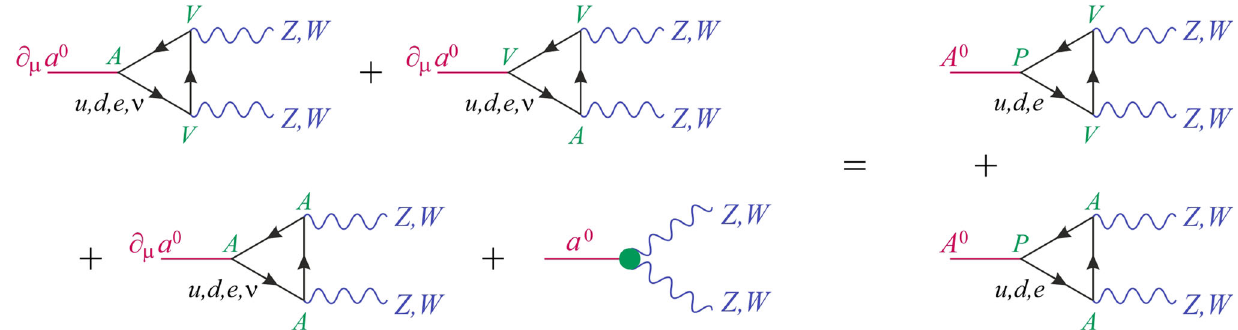
Fig. 5 Contributions to the axion decay into Z Z and W + W − in the polar (left) and linear (right) representations, using the same notations as in Fig. 3. For Z Z , all the SM fermions circulate in the loops in the